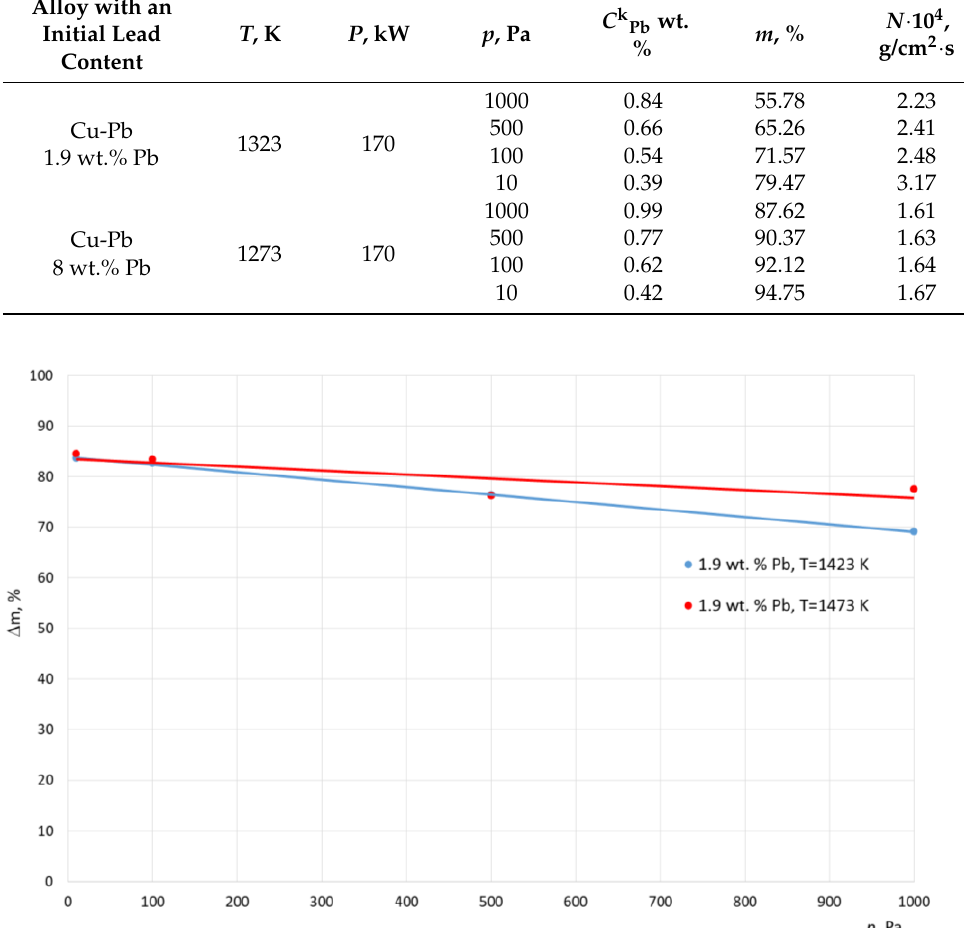
Table 5. Results of experiments carried out in an induction furnace with a cold crucible.